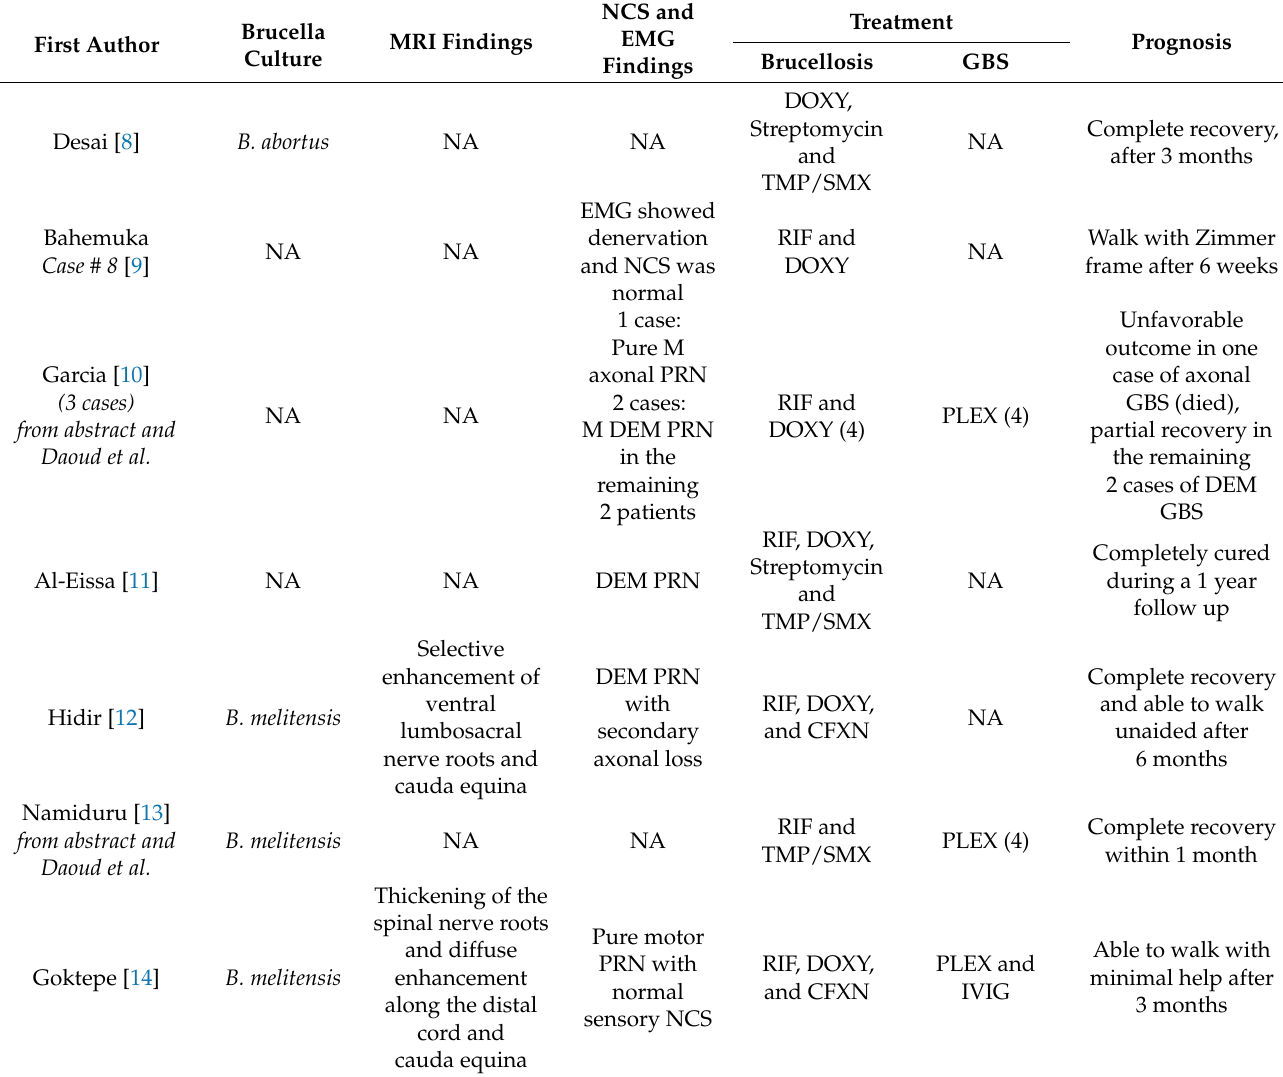
Table 1. Clinical characteristics of published data of patients with Guillain-Barre syndrome and